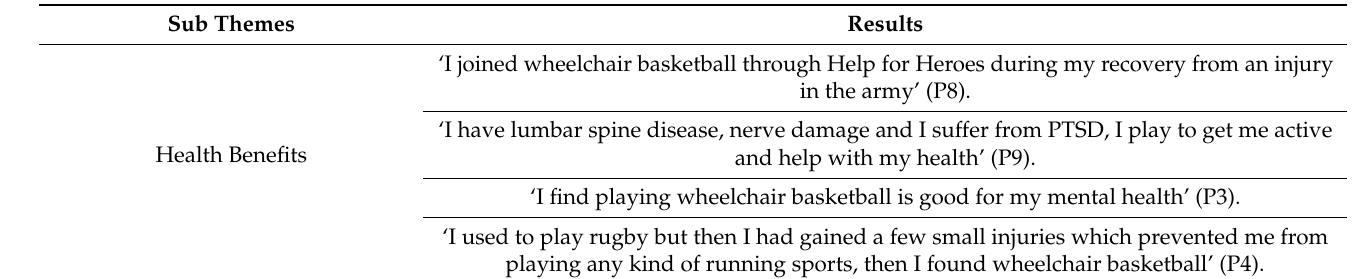
Table 1. Benefits of wheelchair